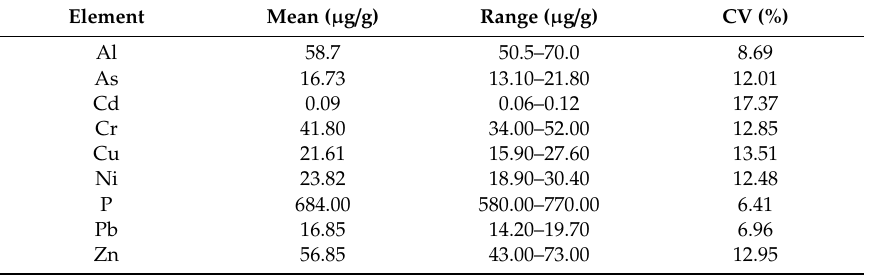
Table 1. The basic statistical parameters of element concentrations in the core ZH4 (n = 20).